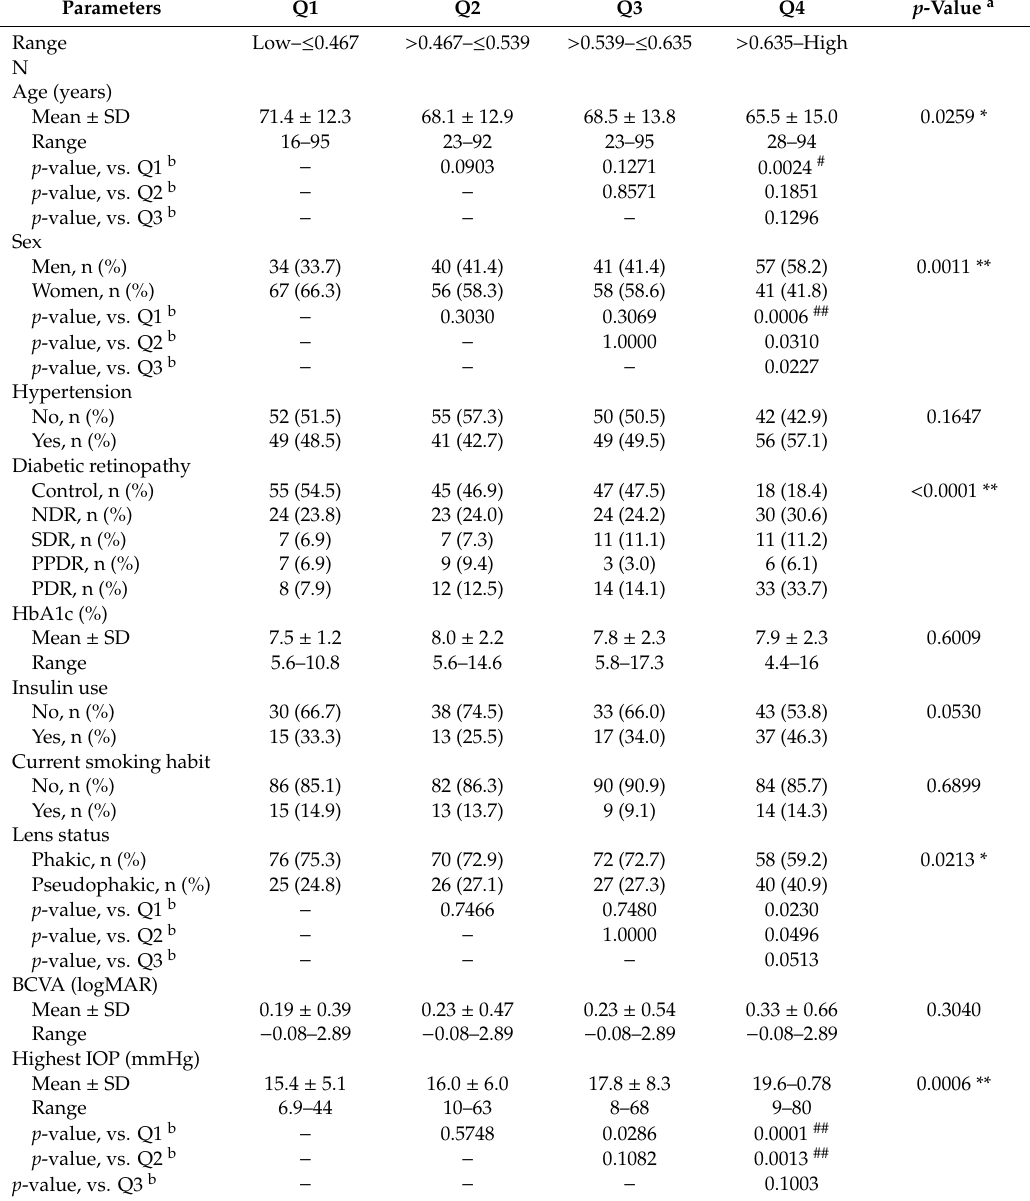
Table 2. Demographic subject data stratified by quartiles of AGE